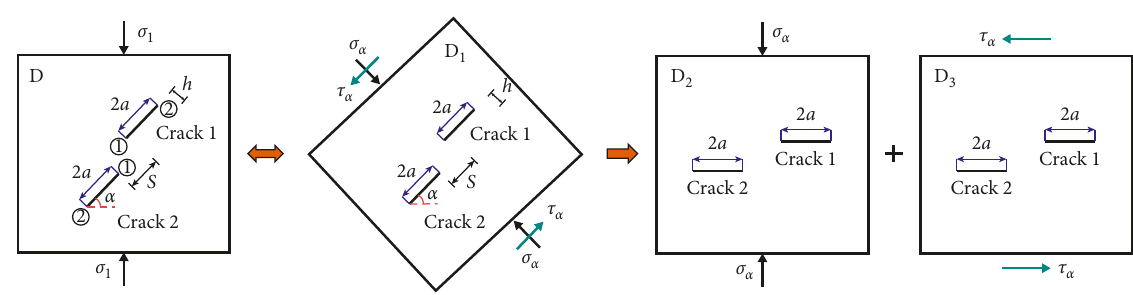
Figure 5: Equivalent sketch of the stress state (D) of rock mass under uniaxial